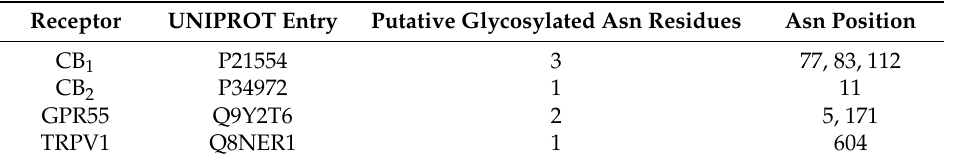
Table 2. Potential N -glycosylation sites detected by sequence analysis of human eCB-binding receptors in the Uniprot database (www.uniprot.org).